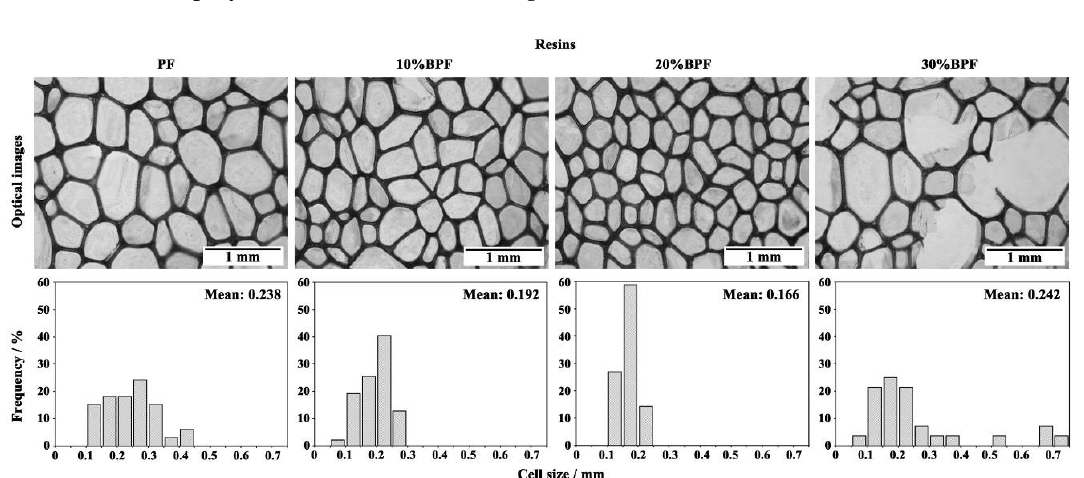
Figure 2. Optical images and cell size distribution of PF and bio-oil phenolic foams (BPFs).